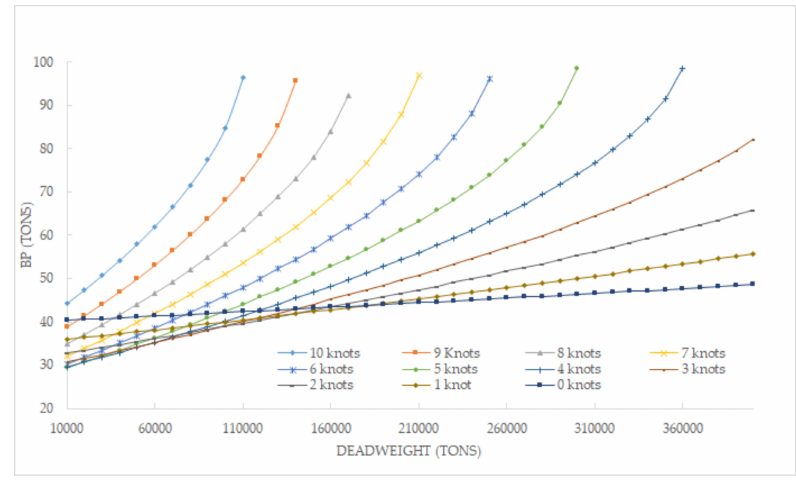
Figure 6. Tug BP needed as a function of ship’s characteristics (constant rudder angle of 25 ◦ ).